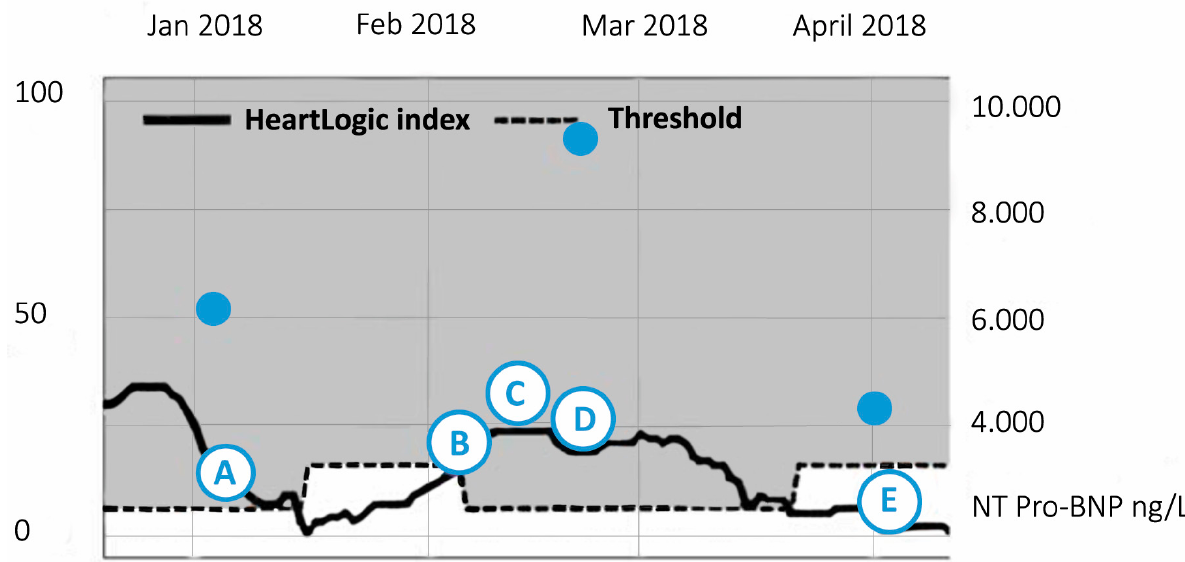
Figure 5. The course of HeartLogic TM index of patient described in Case 1. A (3 January): Inclusion. HeartLogic TM index 8, eGFR (estimated glomerular filtration rate) 44 mL/min/1.73 m 2 , NT pro-BNP (N-terminal B-type natriuretic peptide) 6474 ng/L. B (5 February): Phone contact. HeartLogic TM index 17. C (15 February): Phone contact. HeartLogic TM index 25. D (20 February): Out-patient visit. HeartLogic TM index 22, eGFR 33 mL/min/1.73 m 2 , NT pro-BNP 9650 ng/L. E (2 April): out-